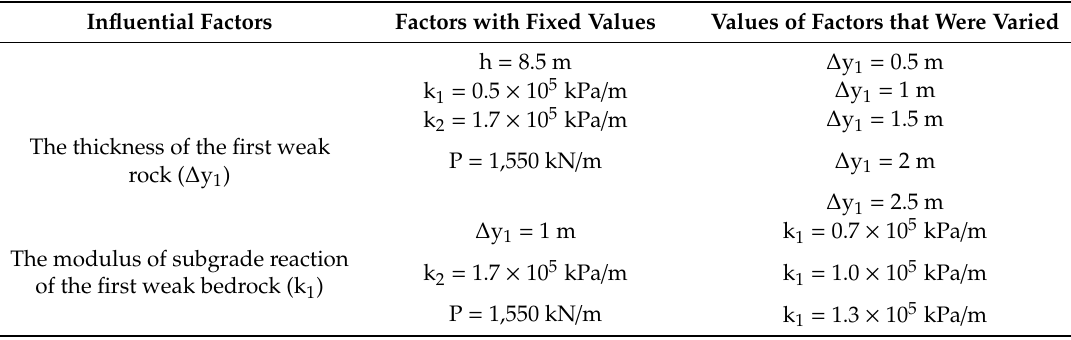
Table 2. Parameters of the calculation model under the change of the main influencing factors. Influential Factors Factors with Fixed Values Values of Factors that Were